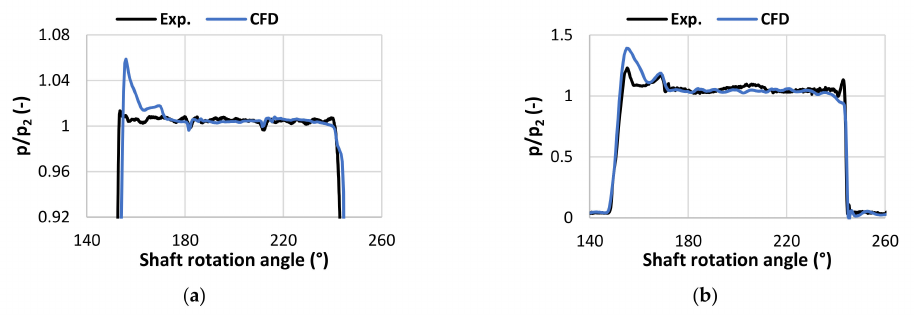
Figure 19. Displacement chamber pressure profiles of the BVP at p 2 = 22.5 bar pressure load and 20 ◦ C oil temperature for 500 rpm ( a ) and 2000 rpm ( b